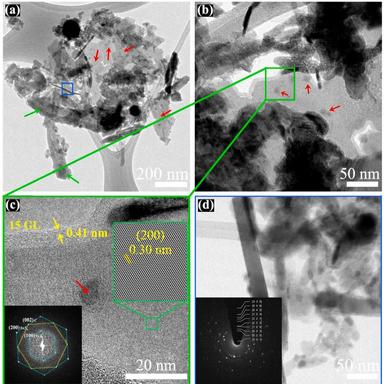
Cristina L. Rodríguez-Corvera et al. TEM and HRTEM micrographs sowing the different structures synthesized at T1 = 230 ◦C. (a) Agglomerate formed by pyrrhotite and troilite structures surrounded by graphite layers (GL). (b) Carbonaceous matrix and pyrrhotite nanoparticles composite, with red arrows, are shown circular and oval shape shades distributed over the iron sulfide nanoparticles. (c) HRTEM images showing the 15 graphitic layers on pyrrhotite. The green highlight frame shows an interlayer distance of